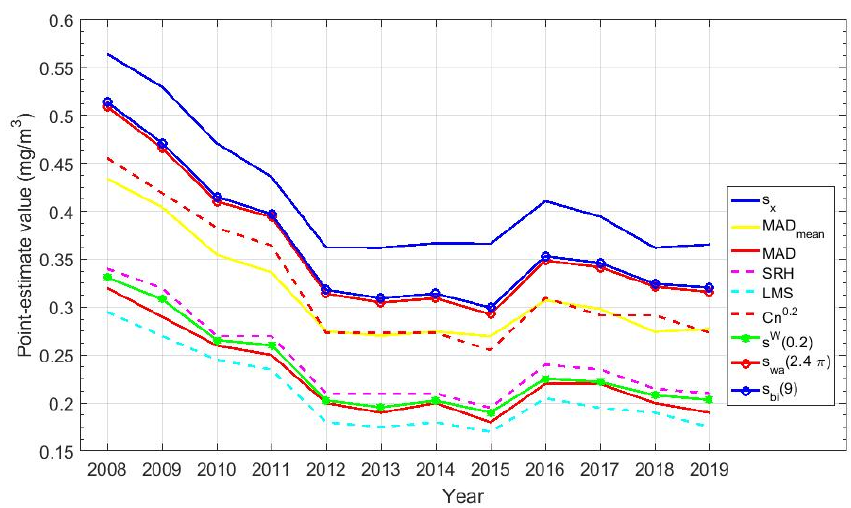
Figure 6. Graphical representation of the scale estimates for the twelve years under study. Scale estimators: sample standard deviation ( S x ), mean absolute deviation ( MAD mean ) , median absolute deviation ( MAD ) , one-half of the fourth-spread ( SRH ), least median squares ( LMS ), estimator based on a subrange ( C α n ), winsorized standard error ( s W ( 0.2 ) ), Andrew’s wave ( s ω a ( 2.4 π ) ), and biweight ( S bi ( c )